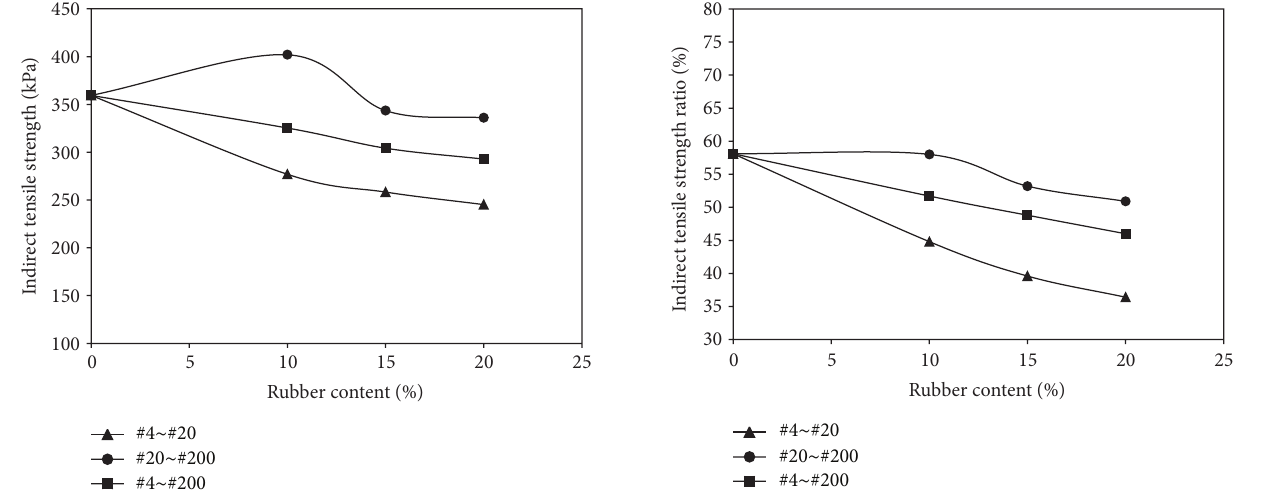
Figure 8: Effect of crumb rubber size and content on indirect tensile (IDT) strength.